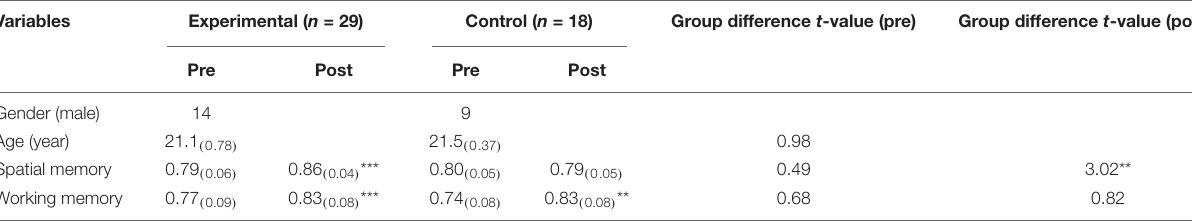
TABLE 1 | Demographic information and spatial memory performance.